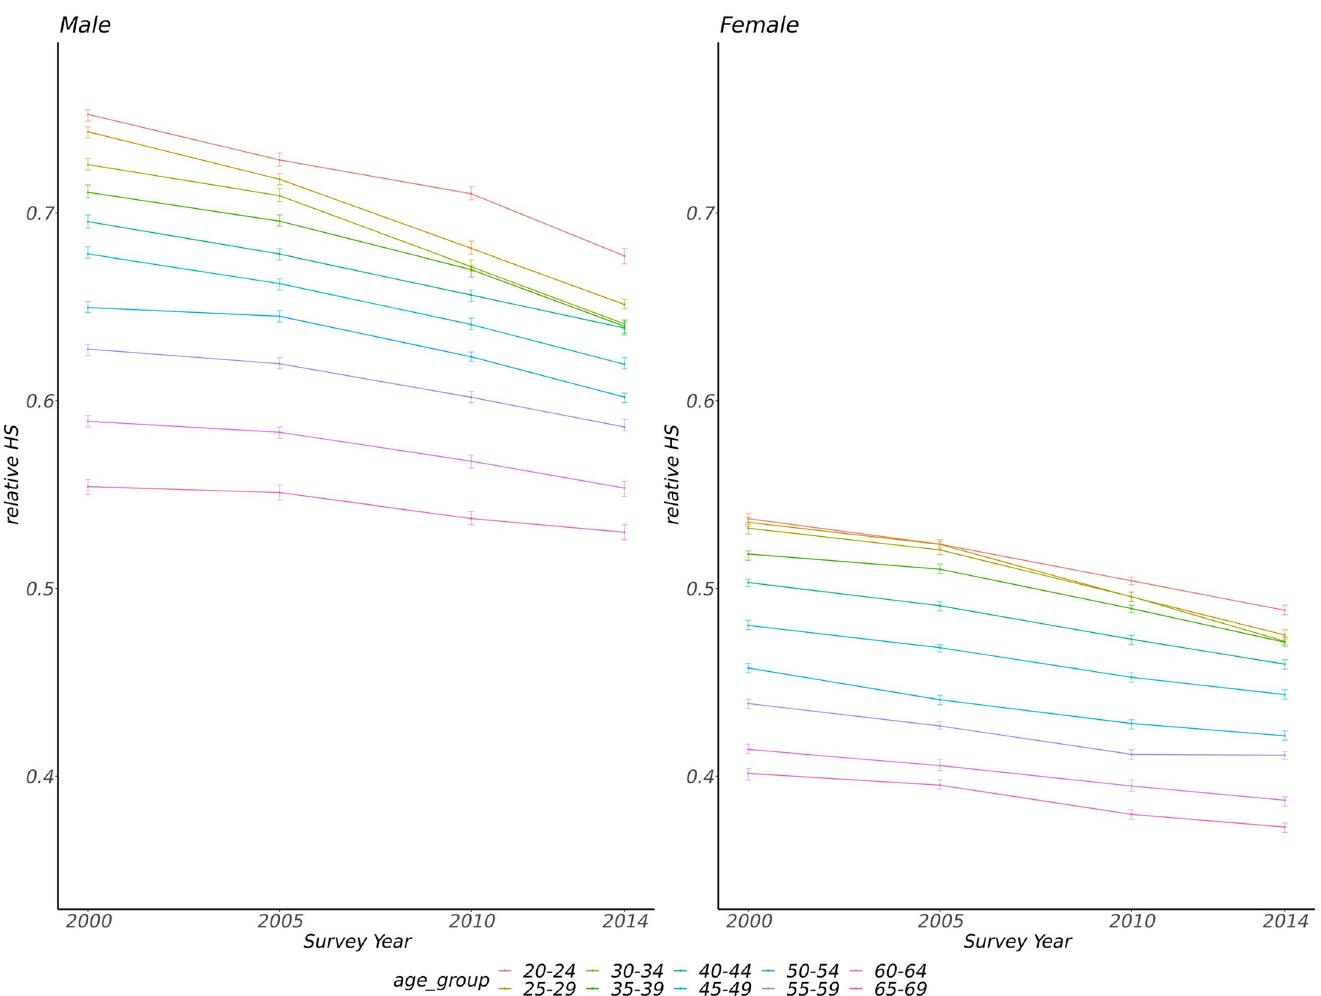
Fig 1. The medians with 95% confidence intervals of relative handgrip strength among different age groups in four survey years (error bars represent 95% confidence intervals for medians).